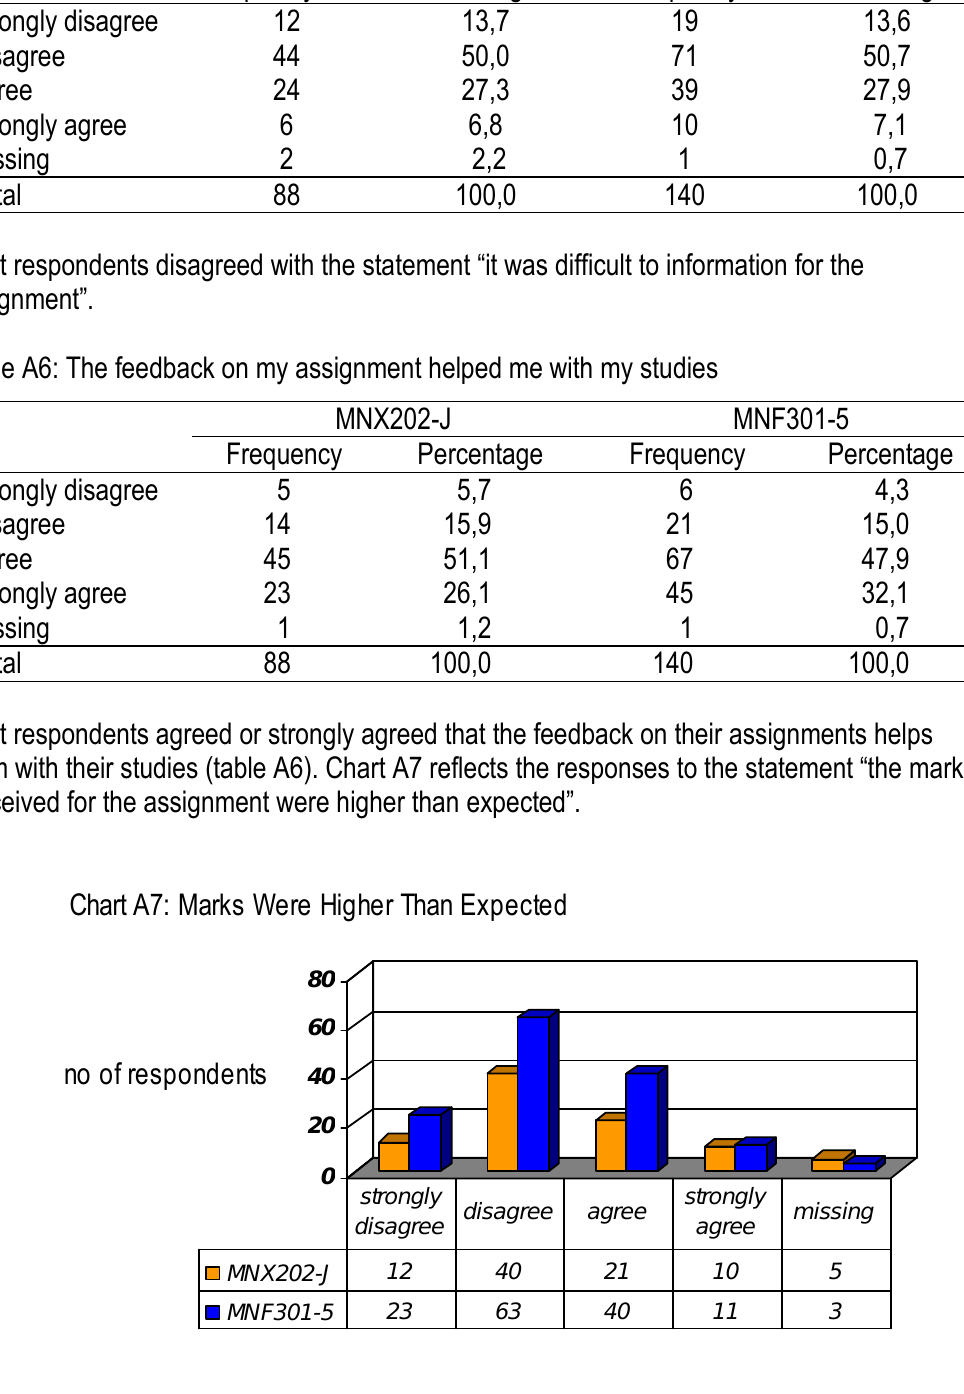
Table A5: It was difficult to find information for this assignment MNX202-J MNF301-5 Frequency Percentage Frequency Percentage Strongly disagree